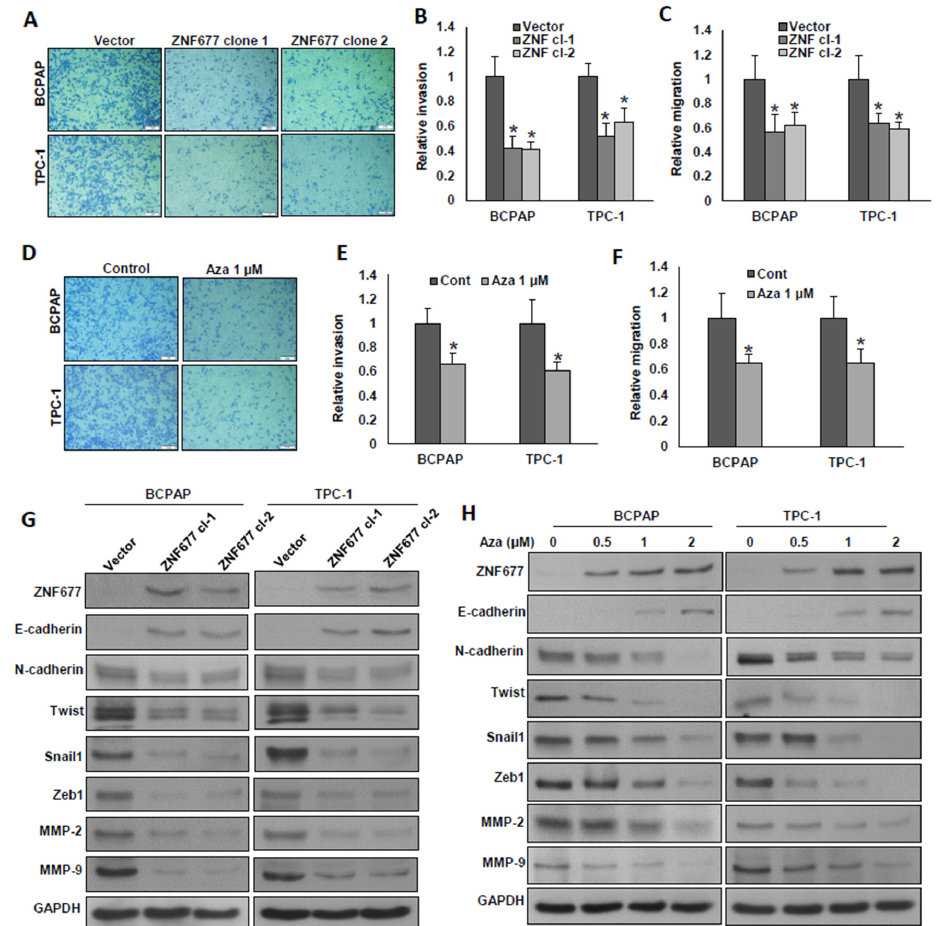
Figure 5. ZNF677 attenuates the metastatic potential of PTC cells. ( A – C ) Forced expression of ZNF677 decreased cell invasion and migration. ZNF677-overexpressing clones were seeded into the upper compartment of invasion or migration chambers. The bottom chambers were filled with RPMI media. After 24 h of incubation, invaded or migrated cells were fixed, stained, and quantified. ( D – F ) Demethylation of the ZNF677 gene decreased cell invasion and migration. PTC cells after treatment with the indicated dose of 5-aza-2 (cid:48) deoxycytidine for 72 h were used for invasion and migration experiments as described before. Data presented by the bar graphs are the mean ± SD of three independent experiments ( n = 3). * Indicates a statistically significant difference compared to control, with p < 0.05. ( G , H ) Forced expression of ZNF677 or demethylation of ZNF677 gene attenuates EMT in PTC cells. Protein extracts from ZNF677-overexpressing clones or cells after treatment with the indicated dose of 5-aza-2 (cid:48) deoxycytidine for 72 h were immuno-blotted with antibodies against ZNF677, E-cadherin, N-cadherin, Twist, Snail1, Zeb1, MMP-2, MMP-9, and GAPDH ( n =